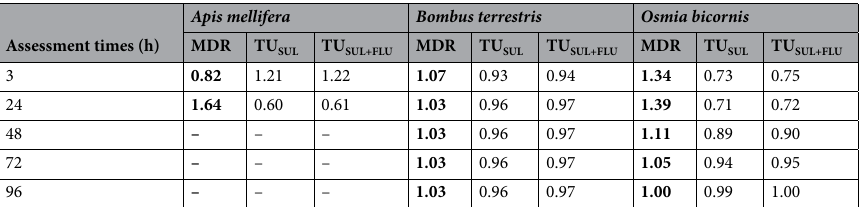
Table 2. Model Deviation Ratio (MDR) and Toxic Unit (TU) values at various assessment times in three bee species exposed to SUL alone and in combination with FLU. TU FLU = 0.0108 (obtained by dividing the fluxapyrozad ingested dose (1.2 µg/bee) by its acute oral LD 50 in Apis mellifera (110.9 µg/bee; 25 ). TU SUL is the ratio between the LD 50 of sulfoxaflor alone and in combination. TU SUL+FLU = TU SUL + TU FLU ; MDR = 1/ TU SUL+FLU . MDR values between 0.83 and 1.25 indicate that combined toxicity follows the Dose/Concentration Addition model. MDR values < 0.83 or > 1.25 indicate antagonism and synergism between the two compounds, respectively 16